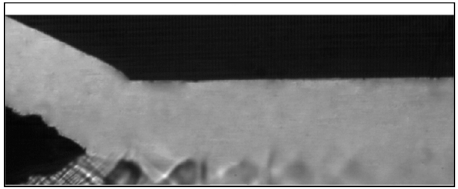
Figure 7. Motive jet condensation in mixing chamber inlet [64].